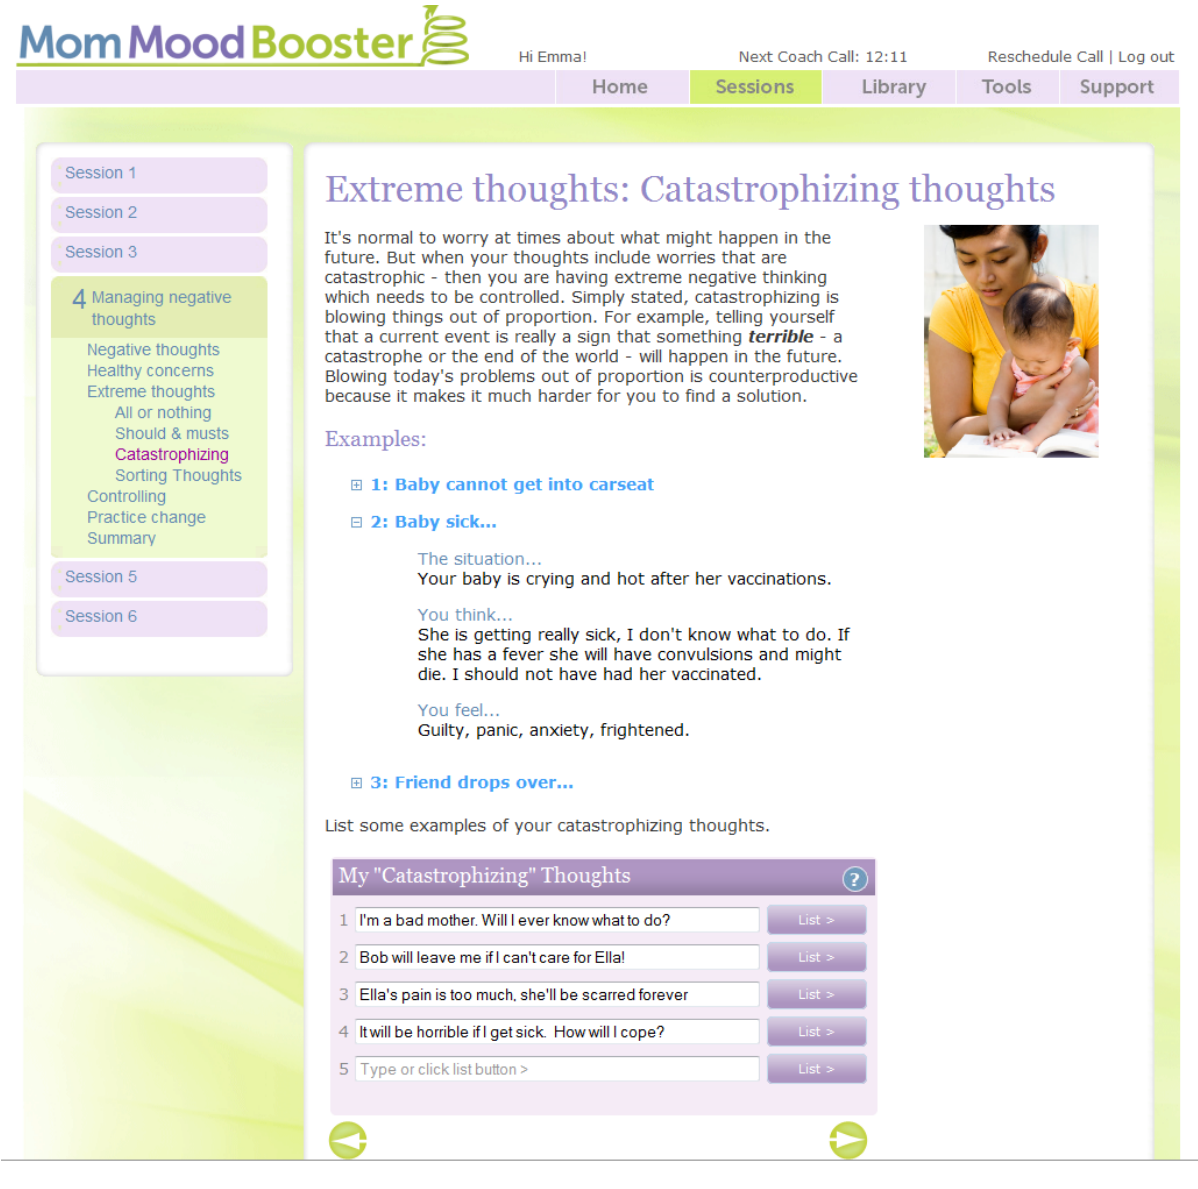
Figure 5. Webpage from MomMoodBooster Session 3 (Displays content participant has entered for personal list of Catastrophisizing